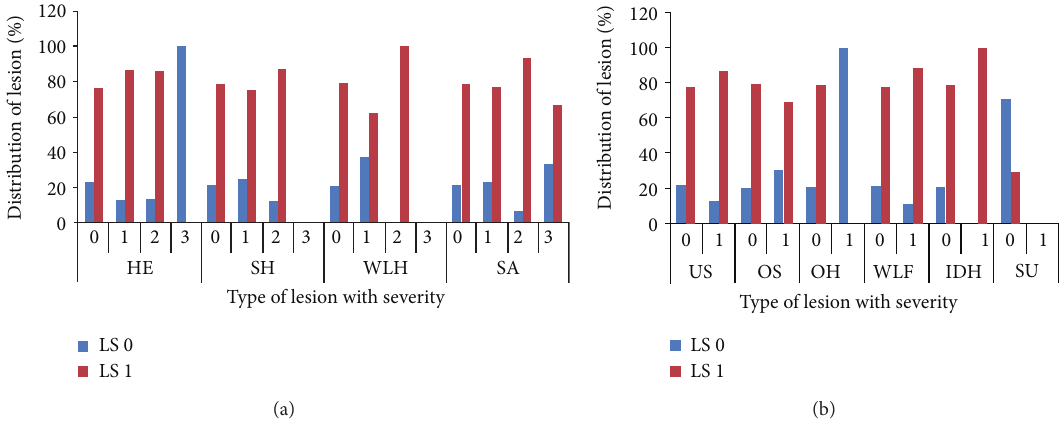
Figure 12: (a) Distribution of severities of lesions in cows with locomotion scores 0 and 1, HE: heel erosion, SH: sole haemorrhage, WLH: white line haemorrhage, SA: sole avulsion, LS: locomotion score. (b) Distribution of severities of lesions in cows with locomotion scores 0 and 1, US: underrun sole, OS: overgrown sole, OH: overgrown hoof, WLF: white line fissure, IDH: interdigital hyperplasia, SU: sole ulcer, LS: locomotion